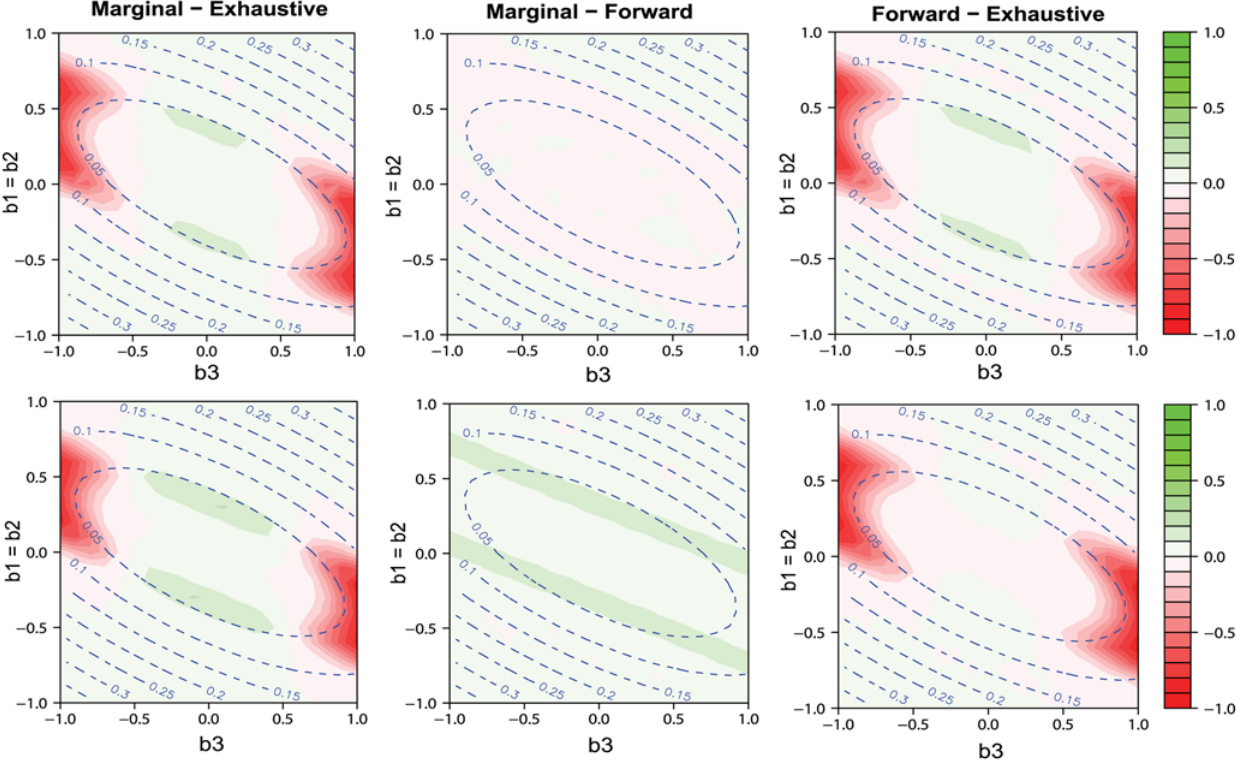
Figure 3. Comparisons among model selection power for detecting either true SNP over genetic model space. The power differences between marginal search and exhaustive search in the left column, between marginal search and forward search in the middle column, and between forward search and exhaustive search in the right column. Green areas indicate positive values of difference, and red areas indicate negative values of difference. We consider genetic models with the main effects b 1 = b 2 varying from 2 1 to 1 and the epistatic effect b 3 varying from 2 1 to 1. The allele frequency q j =0.3, j =1, …, p , and the false discovery number R is set to be 1 in row 1 and 10 in row 2.